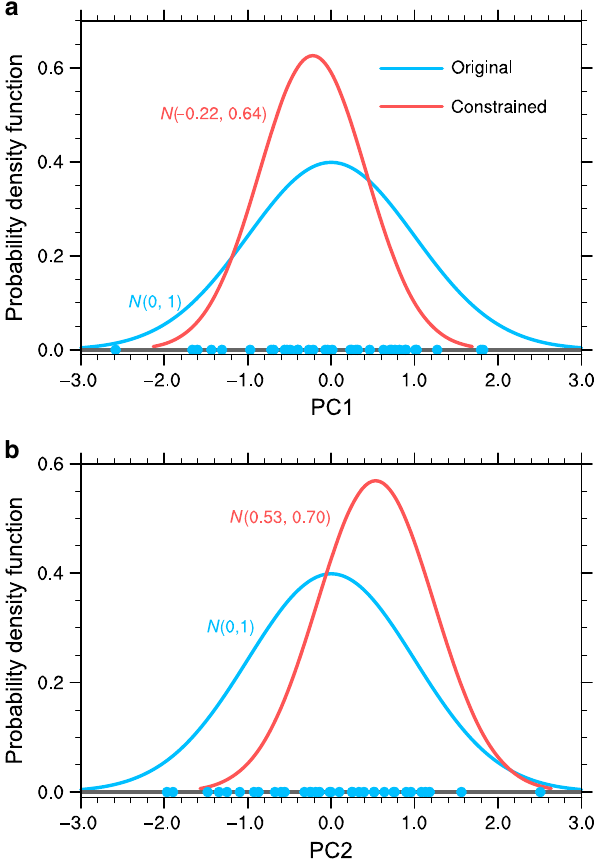
Fig. 3 Probability density function of original and constrained principal components. a , b Probability density functions of the fi rst and second principal components (PC1 and PC2; Supplementary Fig. 2) are generated under Gaussian assumption. The PCs represent the leading intermodel uncertainty modes of the projected changes in the western North Paci fi c Subtropical High. The values in parentheses are mean and standard deviation of the Gaussian distribution. Dots denote the PC values of each